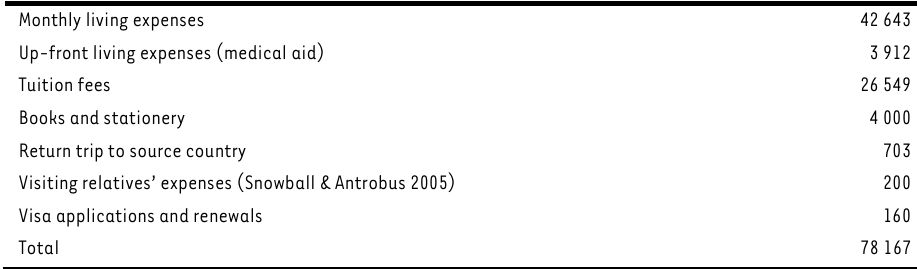
Analysis of survey results, Snowball and Antrobus